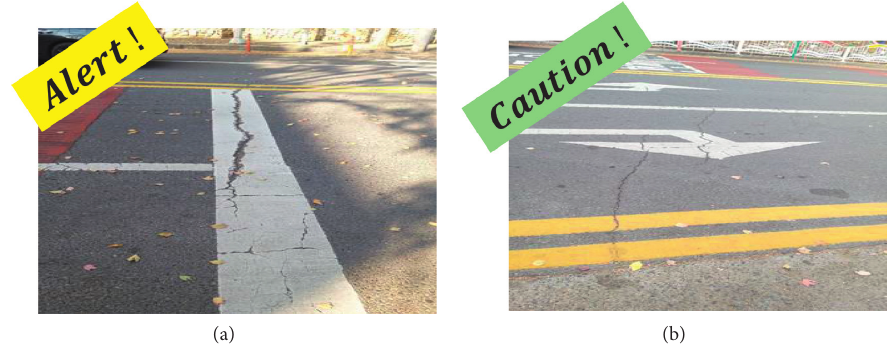
Figure 5: Field survey and analysis results in Gwangju and Daegu cities. (a) Gwangju. (b)